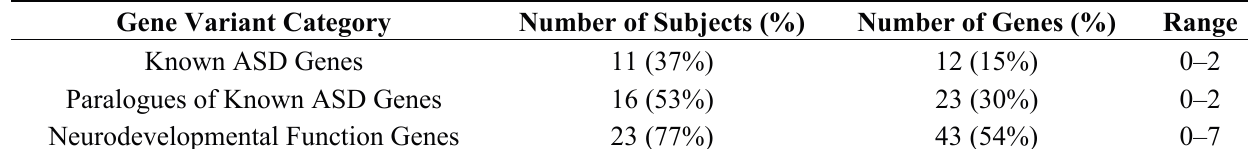
Table 2. Summary of Putative Disease Causing Gene Variants Identified by Exome Sequencing. Gene Variant Category Number of Subjects (%) Number of Genes (%) Range Known ASD Genes 11 (37%) 12 (15%) 0–2 Paralogues of Known ASD Genes 16 (53%) 23 (30%) 0–2 Neurodevelopmental Function Genes 23 (77%) 43 (54%) 0–7 Six females (HI0605, HI2898, HI1739, HI2172, HI2244 and HI2879) possessed a single variant